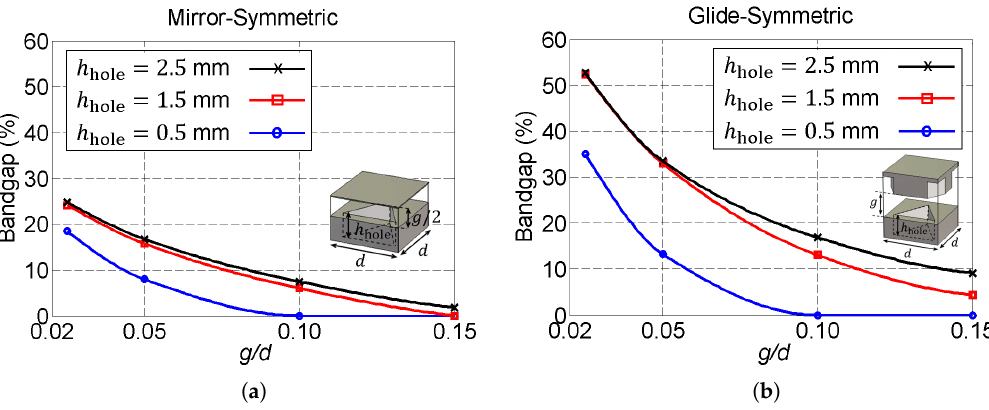
Figure 12. Relative bandgap in the ( a ) mirror-symmetric and ( b ) glide-symmetric structures with equilateral triangular holes as a function of the gap height g and the hole depth h hole . The geometrical parameters of the considered unit cells are: h t = 3.8mm, and d =